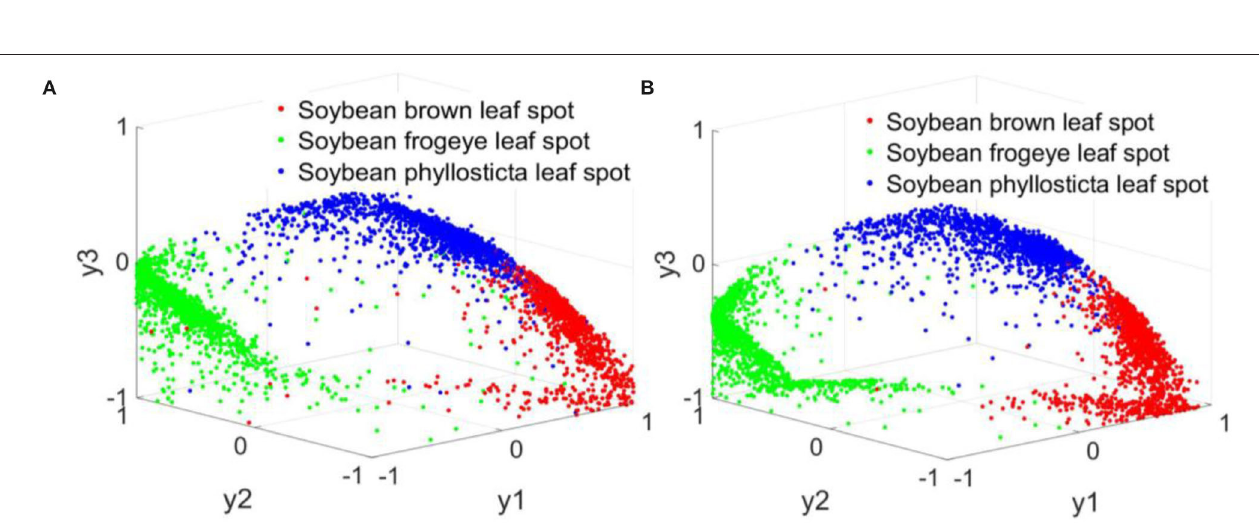
FIGURE 19 | Normalization results of simulation calculation. (A) ResNet18. (B) RANet.